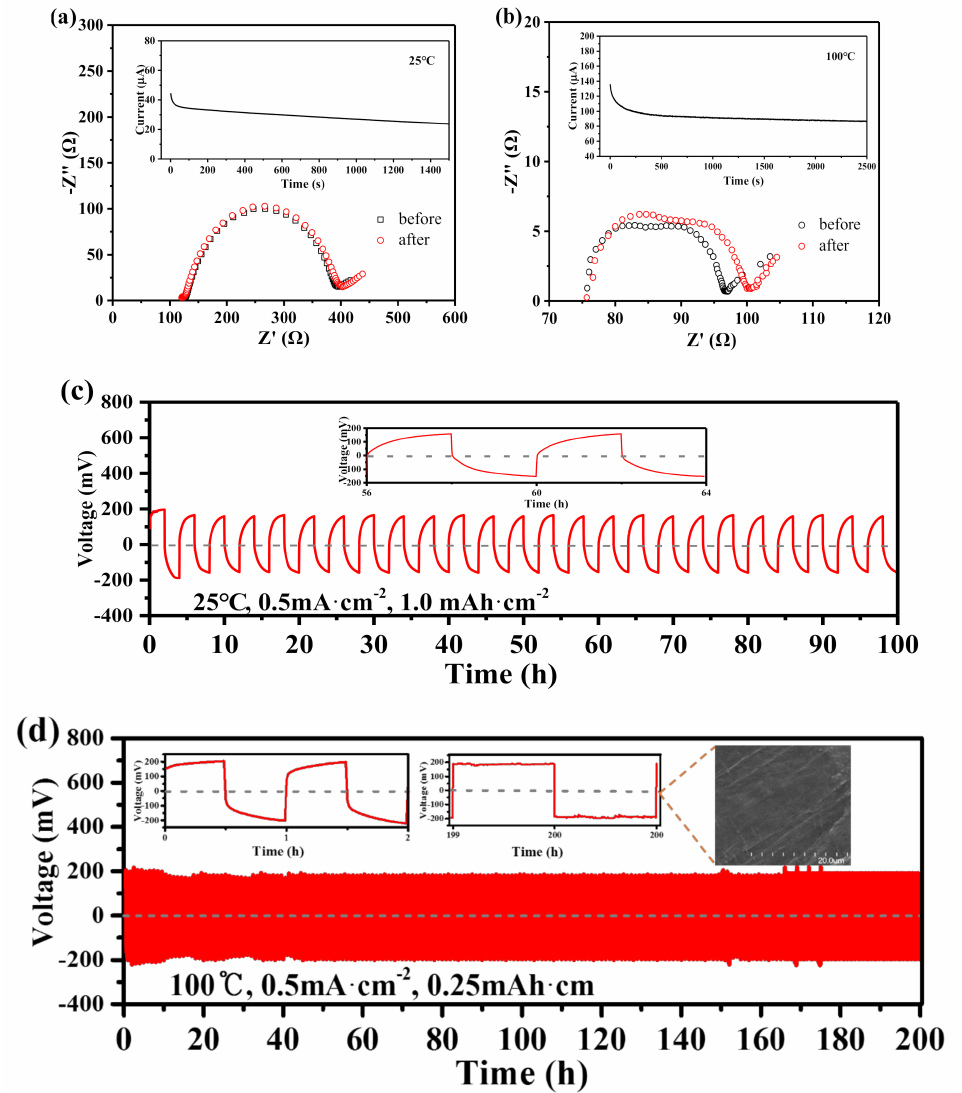
Figure 4. ( a , b ) EIS of Li|HKUST-1@IL-Li|Li cell at initial and steady states (insets: current–time profiles during polarization process) at room temperature, 25 ◦ C and high temperature, 100 ◦ C. ( c , d ) Galvanostatic cycling of Li plating/stripping at room temperature, 25 ◦ C, with 0.5 mA · cm − 2 current density, 1.0 mAh cm − 2 areal capacity, and insets of the enlarged voltage profiles for 56–64 h, high temperature, 100 ◦ C, with 0.5 mA · cm − 2 current density, 0.25 mAh cm − 2 areal capacity, and insets of the enlarged voltage profiles for 0–2 h, 199–200 h, and the surface SEM images of Li metal anode after the plating/stripping